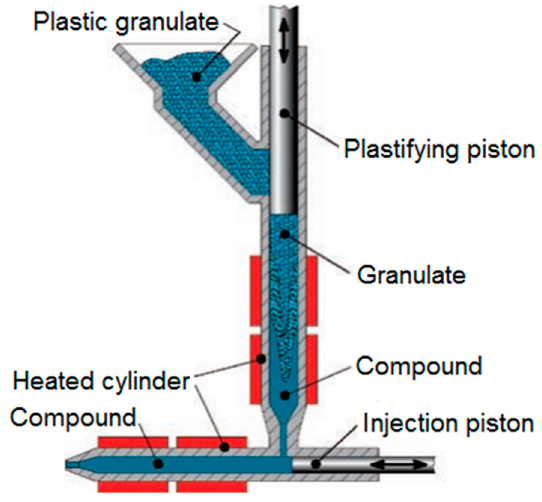
Figure 5. Working principle of FormicaPlast 2K [16].